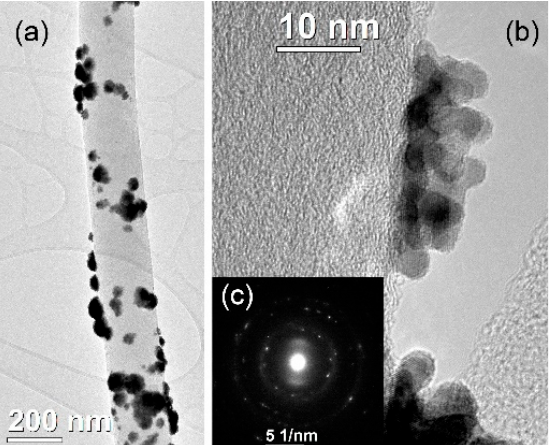
Figure 3. BF TEM images of CNF: ( a ) Pt on a CNF with smooth surface; ( b ) Pt agglomerate and ( c ) SAED pattern for sample 2 .